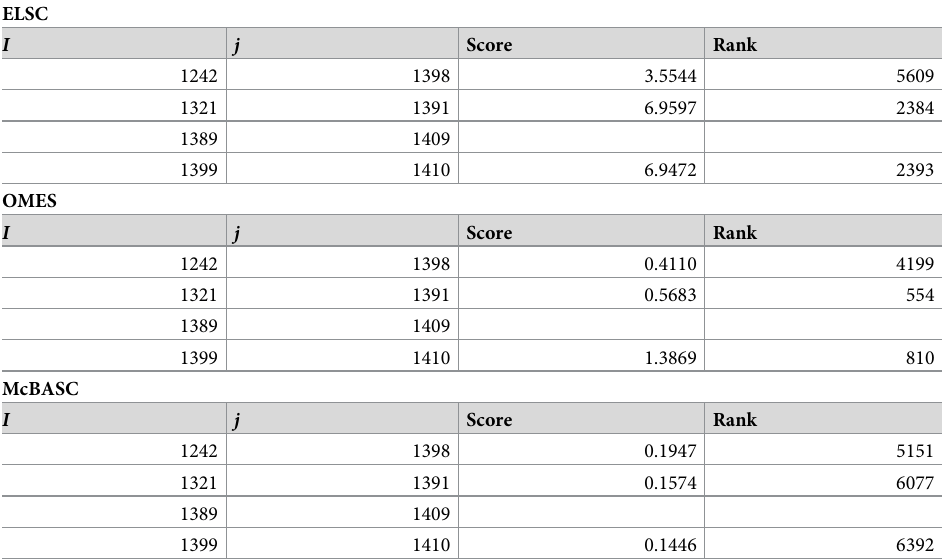
The scores and rank for given for coupled positions ( i , j ) for each covariance algorithm is shown with the rank representing the coupled positions’ score with respect to all the coupled positions in its covariance algorithm and MSA. For this table, all ranks are out of 24,090 coupled positions. The scrambled values for ELSC, OMES and McBASC are 11.0010, 1.8764, 0.9693